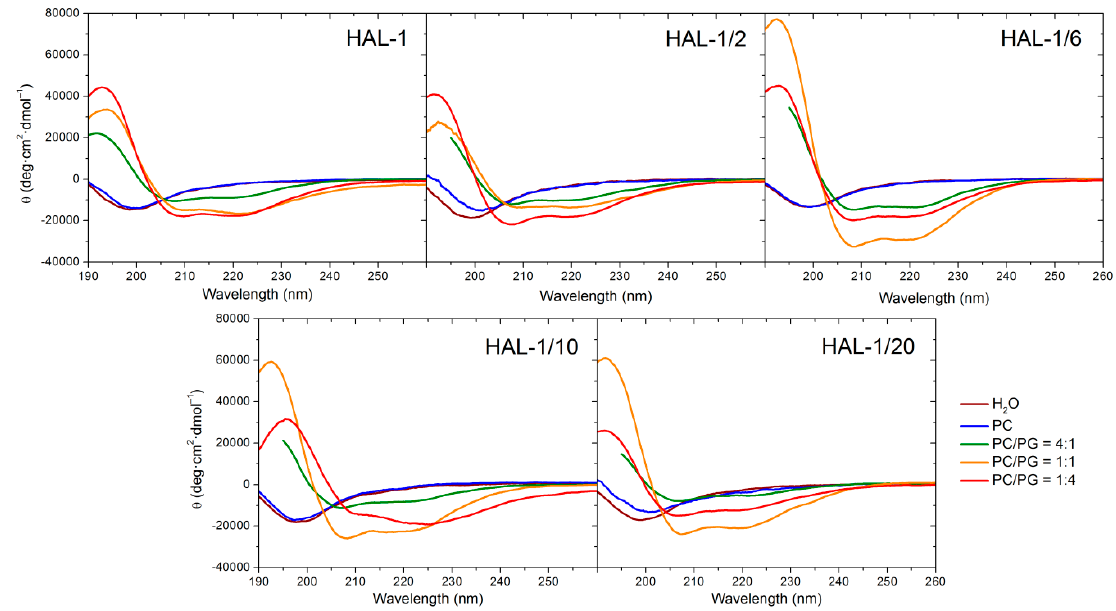
Figure 4. ECD spectra of HAL-1 and its analogs (0.125 mg/mL) in aqueous solution and in the presence of LUVs (L/P = 20) prepared from PC and PC/PG mixtures: 4:1, 1:1 and 1:4.